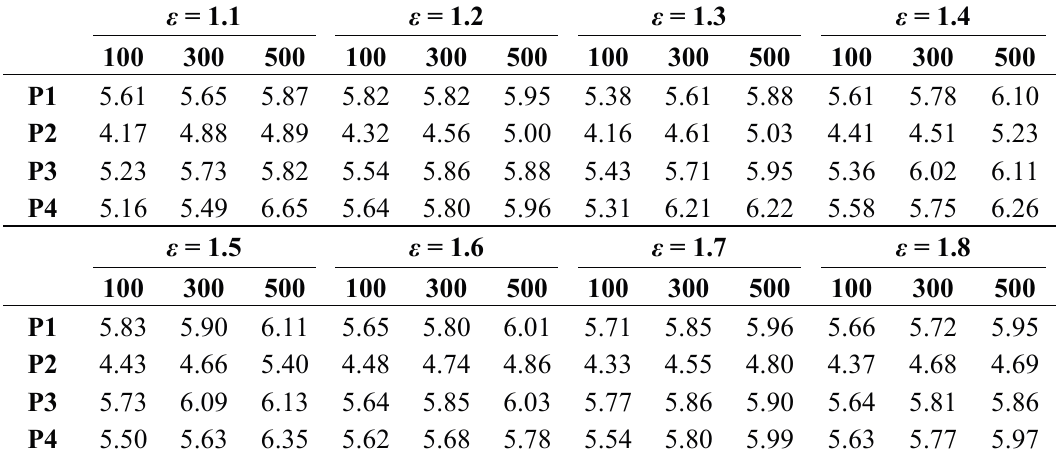
Table 2. The number of Pareto optimal solutions obtained by four different penalty functions. ε = 1.1 ε = 1.2 ε = 1.3